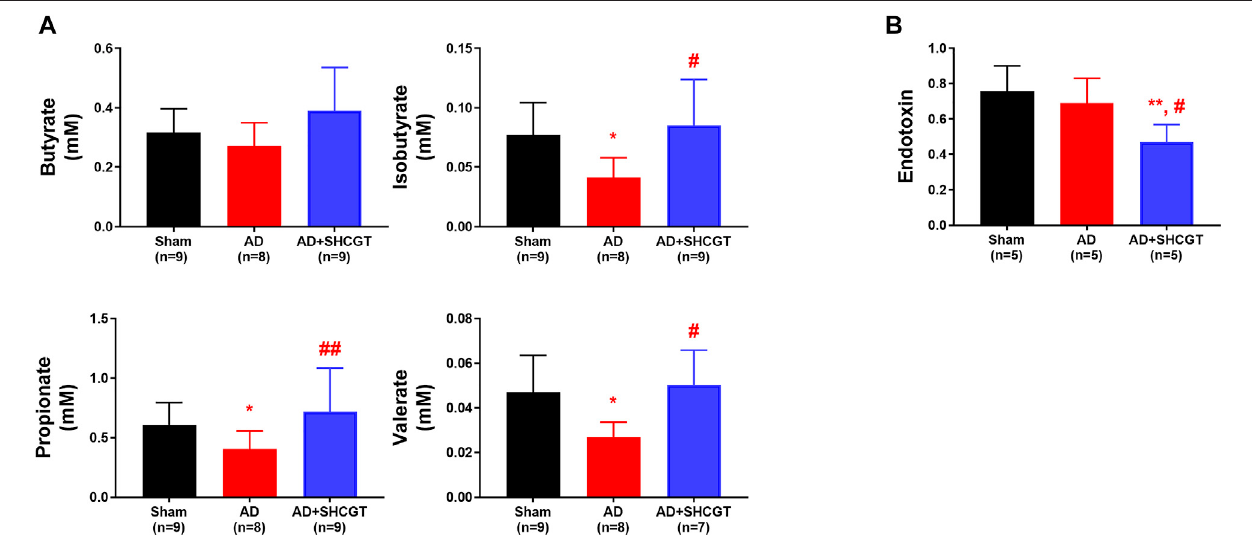
FIGURE 7 | SHCGT regulated gut microbiome-related metabolites and short-chain fatty acids and reduced endotoxin levels. (A) Concentrations of short-chain fatty acids, including butyrate, isobutyrate, propionate, and valerate. SHCGT signi fi cantly increased the isobutyrate, propionate, and valerate levels in mice with